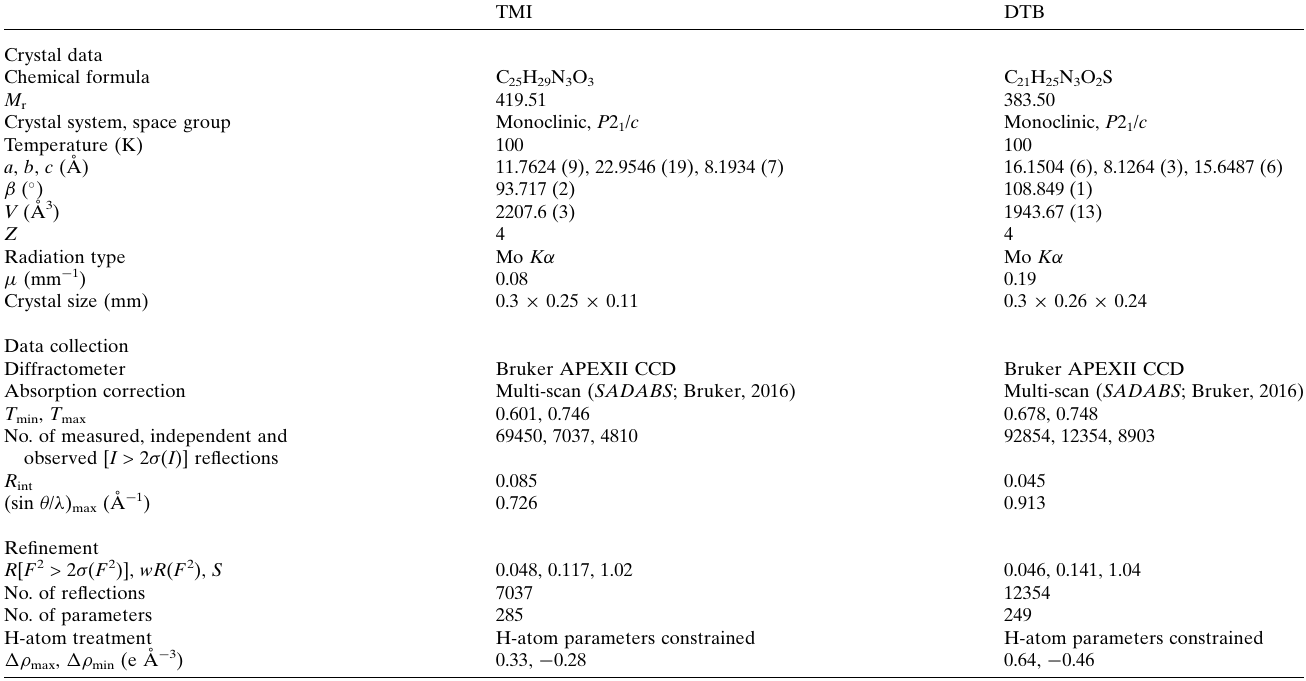
Table 3 Experimental details.